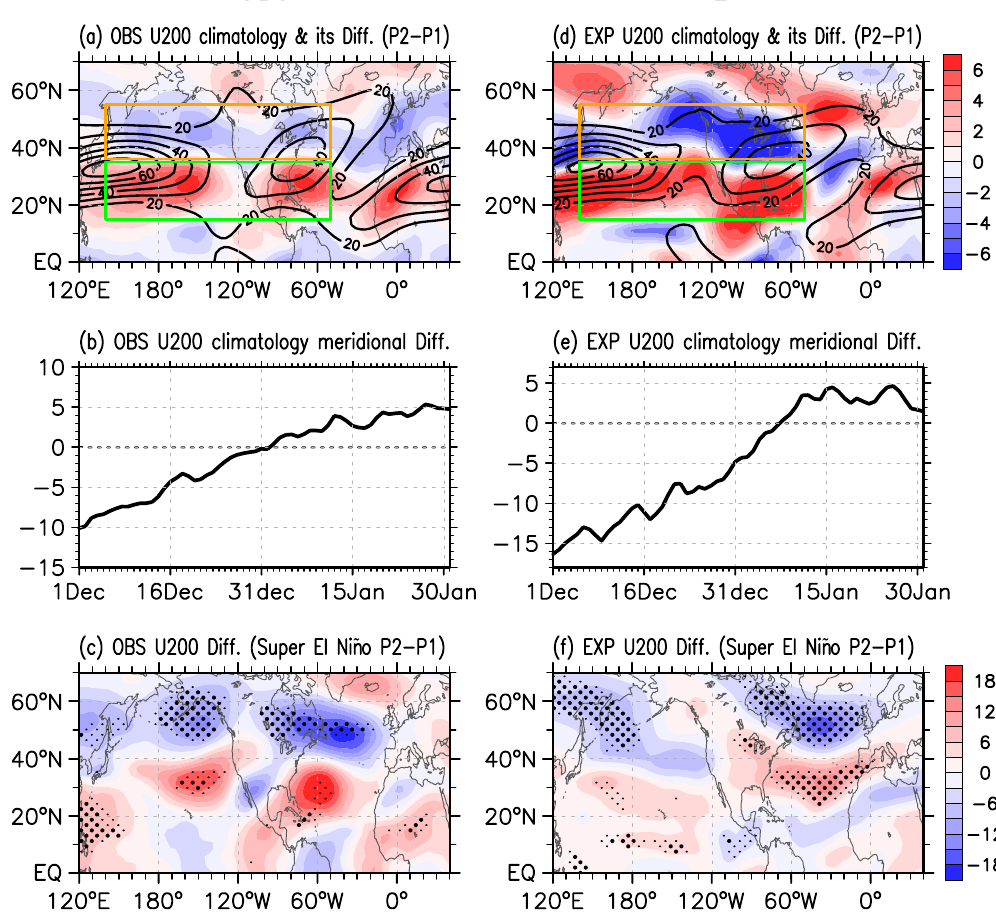
Figure 5. Climatological subtropical jet and its sub-seasonal variations during super El Niño winters. ( a ) 200-hPa zonal wind climatology during P1 and P2 (contours in m/s, from 20 to 70 by 10), and its differences between P2 and P1 (shading in m/s); ( b ) Meridional difference of the 200-hPa zonal wind climatology between the southern (15–35°N, 140°E–50°W, green box) and northern (36–55°N, 140°E–50°W, orange box) parts of the subtropical jet; ( c ) Differences of the 200-hPa zonal wind anomalies (shading in m/s) between super El Niño P2 and P1. ( d–f ) Same as ( a–c ), but for the GFDL AM2.1 model simulations. Small and big black dots indicate the differences above the 90 and 95% confidence levels, respectively. The figure was generated with the NCAR Command Language (Version 6.3.0) [Software] (2015). Boulder, Colorado: UCAR/NCAR/CISL/TDD. http://